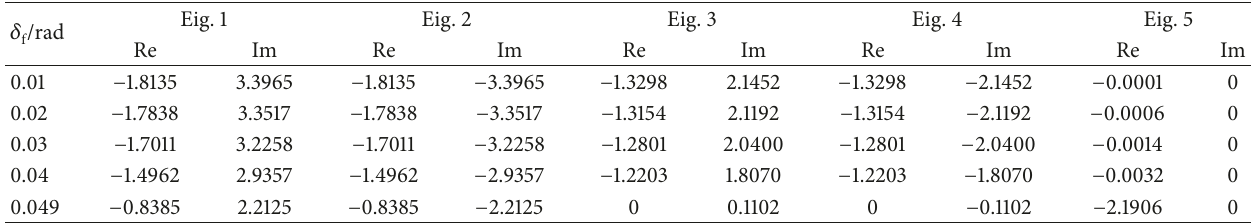
Table 3: Calculated eigenvalues of Jacobian matrix 𝐴 under various front wheel steering